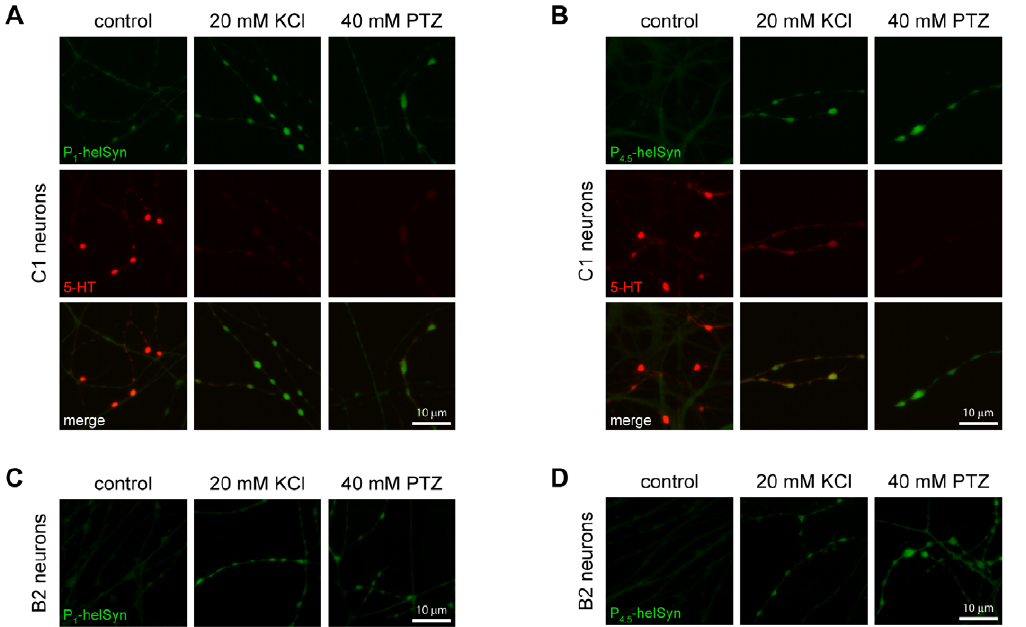
Figure 7. PTZ-induced epileptiform activity promotes massive neurotransmitter release and phosphorylation of synapsin at presynaptic varicosities. Epifluorescence micrographs sample images of Helix C1 neurites and varicosities immunolabelled with rabbit a -P 1 helSyn (A) or a -P 4,5 helSyn antibodies (B), in green. Cells were fixed after 15 minutes of incubation with culture medium (control, left of each panel), or 20 mM KCl (middle of each panel) or 40 mM PTZ (right of each panel). Both treatments increased synapsin phospho-levels of site 1 and sites 4/5. A double staining for serotonin (5-HT), in red, revealed a strong loss of immunoreactivity, indicative of a massive neurotransmitter release in KCl and PTZ- treated cells. Sample images of Helix B2 neurites and varicosities treated as above described and then immunolabelled with rabbit a -P 1 helSyn (C) or a -P 4,5 helSyn antibodies (D). Scale bars: 10 m m.